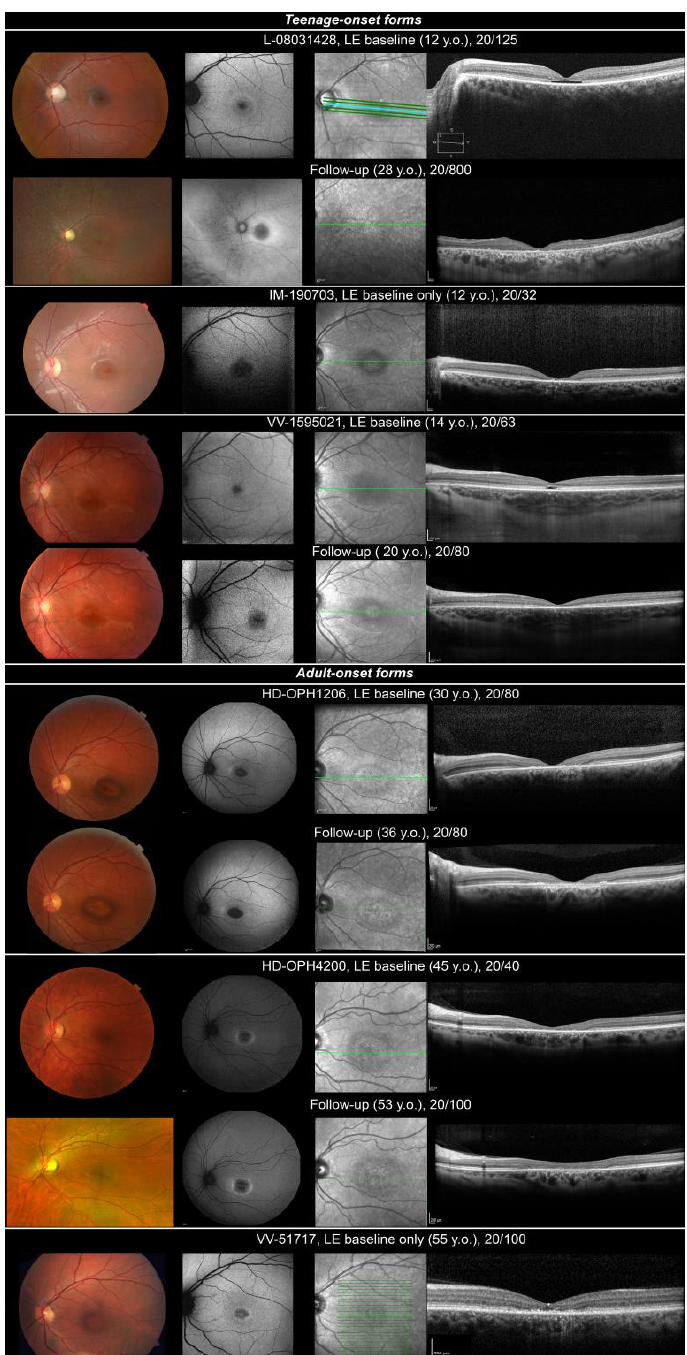
Figure 1. Ocular findings in isolated retinal dystrophy linked to MFSD8 variants. Fundus pho- tography, SW-FAF, IRR and HD-OCT are shown in successive rows. Top, teenage-onset macu- lopathy/COD/CORD. Optic disc pallor and a punched-out atrophic foveal lesion with slightly hyperpigmented borders. Foveal lesion looked dark with hyperautofluorescent edges on SW-FAF. SD-OCT found either a temporary aspect of foveal cavitation in outer reflective layers (L-08031428, VV-1595021) or a larger destruction of outer layers (IM-190703) in the macula. Slow progression of macular lesions at follow-up, progression to a more widespread retinal lesions with mid-peripheral involvement in patient L-08031428. Bottom, adult-onset maculopathy/COD. Bull’s eye maculopa- thy. Dark fovea with hyperautofluorescent edges on SW-FAF corresponding to a more or less large interruption of outer reflective layers on SD-OCT. Slow progression of macular lesion at